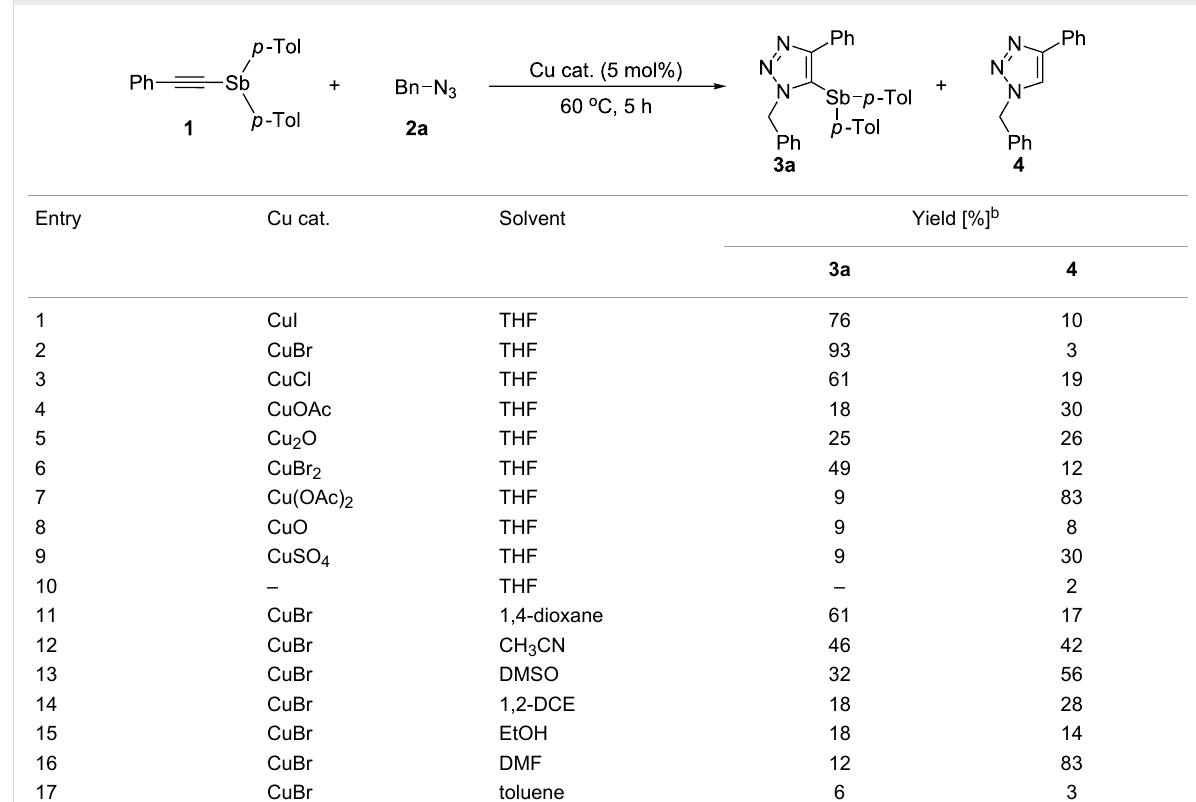
Table 1: Cu-catalyzed reaction of ethynylstibane 1 with benzylazide 2a a .